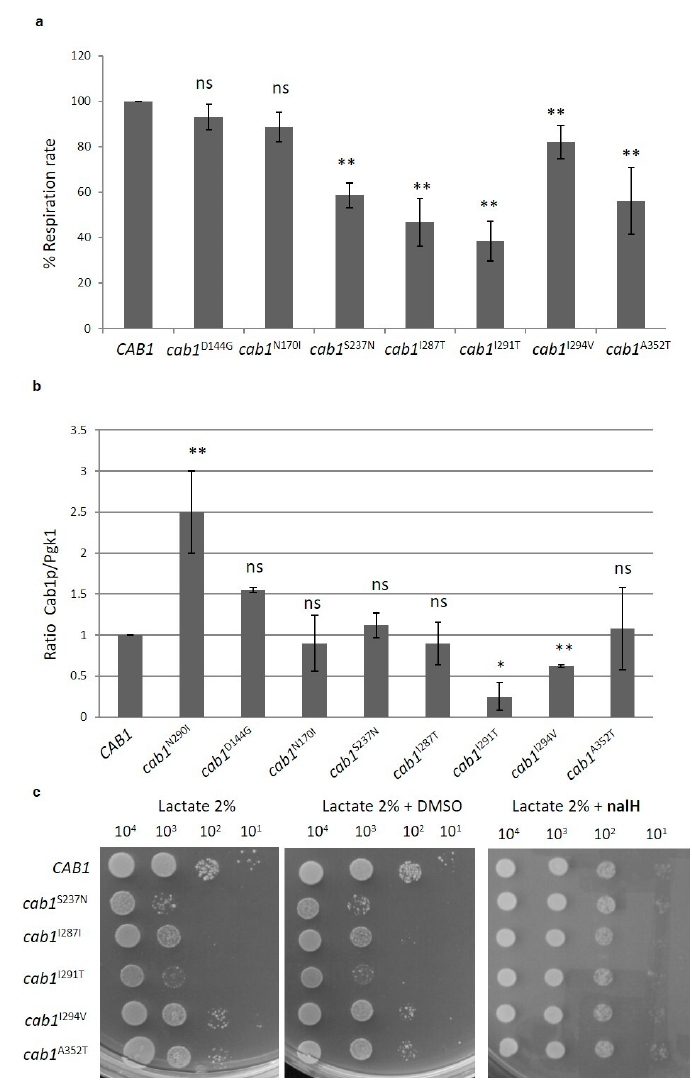
Figure 7. ( a ) OCR was measured in wild-type and mutant strains grown at 37 ◦ C in SC medium supplemented with 0.6% glucose. Values are means ± standard deviation. The OCR was normalized to the strain transformed with the CAB1 wild-type allele. Values are means ± standard deviation. N = 3; n = 9 for each strain. **: p < 0.01; ns: not significant. ( b ) Steady state level of Cab1 protein in wild-type and mutant strains. The proteins were extracted from wild-type and mutant strains grown at 37 ◦ C, or 28 ◦ C for cab1 N290I , in SC medium supplement with 0.6% glucose. Quantification of protein bands was performed using the Image Lab software. N = 2; n = 2 for each strain. *: p < 0.05; **: p < 0.01; ns: not significant. ( c ) Equal amounts of serial dilutions of wild-type and mutant strains from exponentially grown cultures were spotted (10 4 , 10 3 , 10 2 , 10 1 cell/spot) onto SC medium plates supplemented with 2% lactate, 2% lactate with DMSO and 2% lactate with 31 µ M nalH. The growth was scored after 4 days of incubation at 37 ◦ C. The experiment was performed on at least three independent clones for each strain ( N = 2; n =